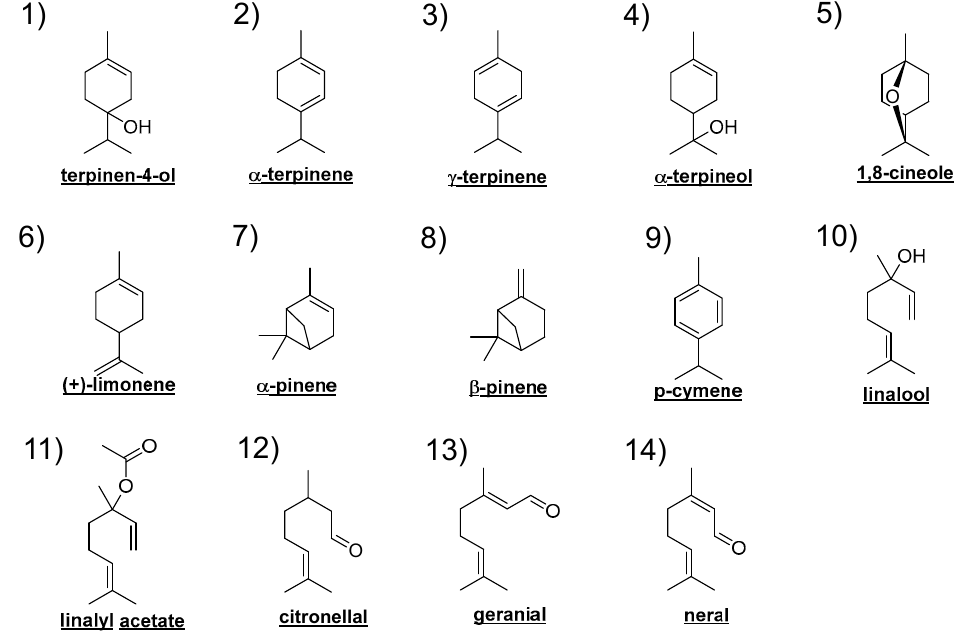
Figure 1. Structural formulae of 14 effective components in this study. ( 1 ) terpinene-4-ol, ( 2 ) α - terpinene, ( 3 ) γ -terpinene, ( 4 ) α -terpineol, ( 5 ) 1,8-cineole, ( 6 ) (+)-limonene, ( 7 ) α -pinene, ( 8 ) β -pinene, ( 9 ) p-cymene, ( 10 ) linalool, ( 11 ) linalyl acetate, ( 12 ) citronellal, ( 13 ) geranial, ( 14 ) neral.